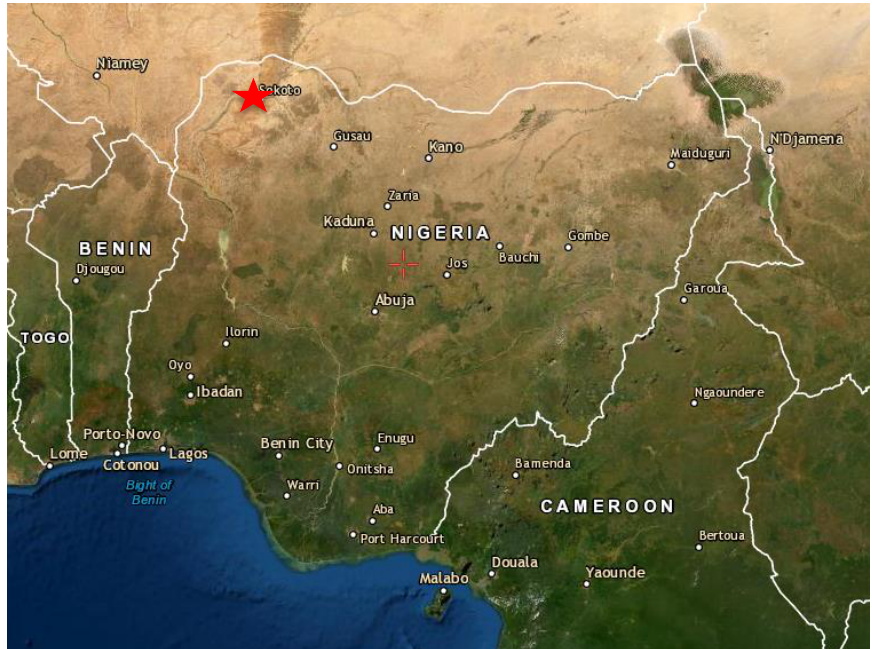
Figure 1. Location of Sokoto State in